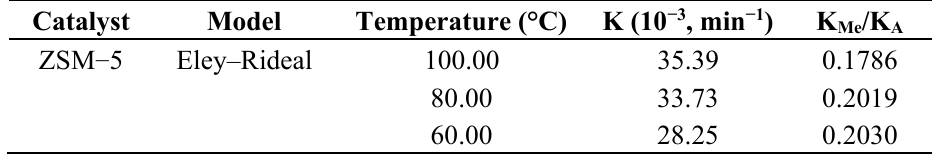
Table 3. Rate constants and Equilibrium constant for Eley–Rideal